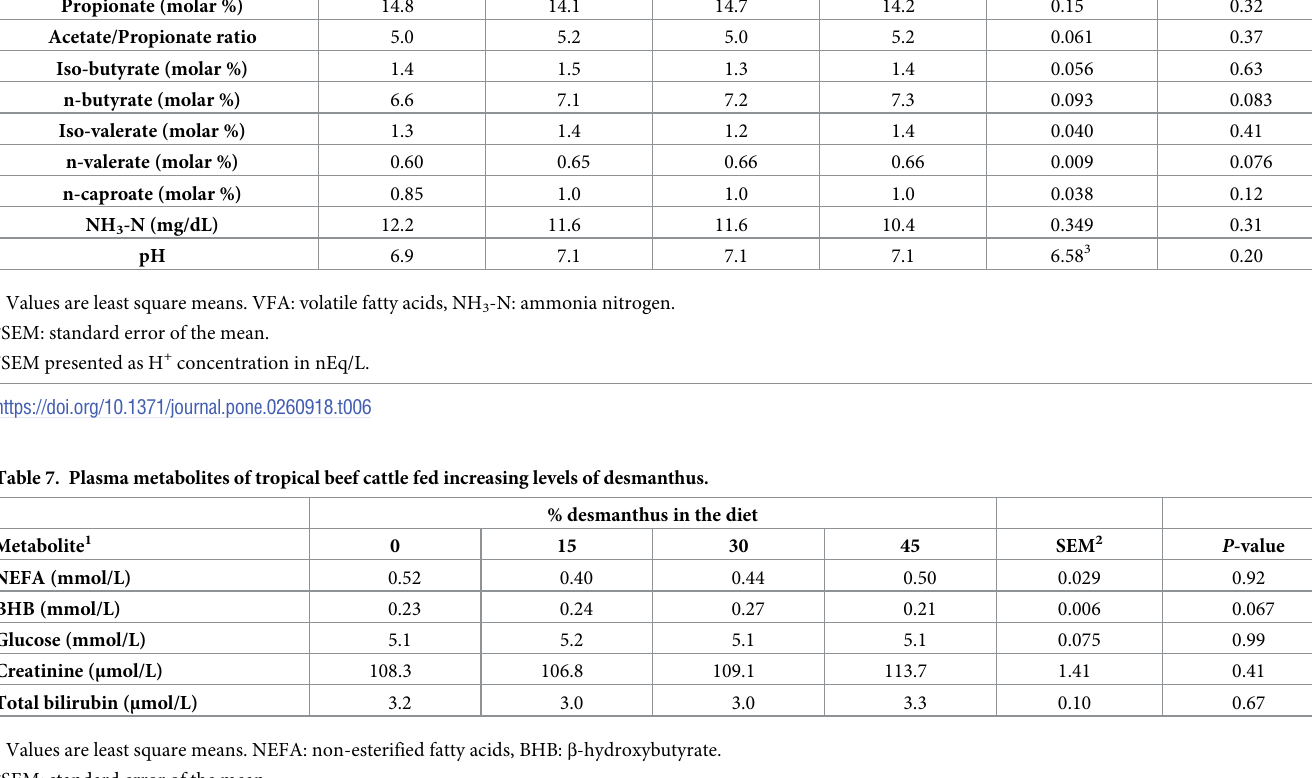
% desmanthus in the